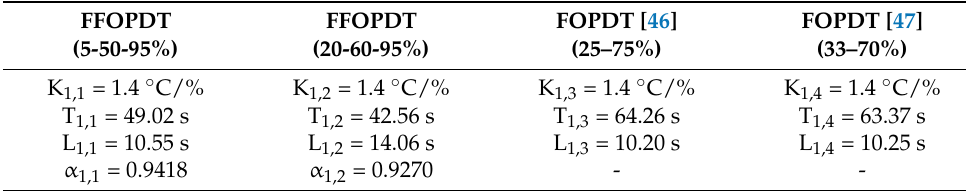
Table 7. Model parameters obtained using the considered identification method for FFOPDT models using (5-50-95%) and (20-60-95%), and the ones using identification methods proposed by Alfaro and Viteckov á for FOPDT